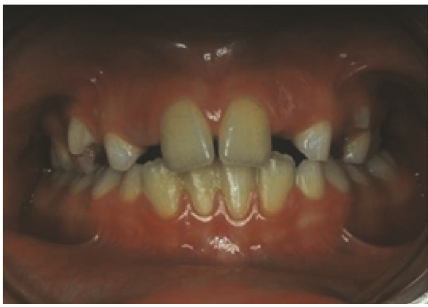
Figure 1: Patient with crossbite of upper left first permanent molar.